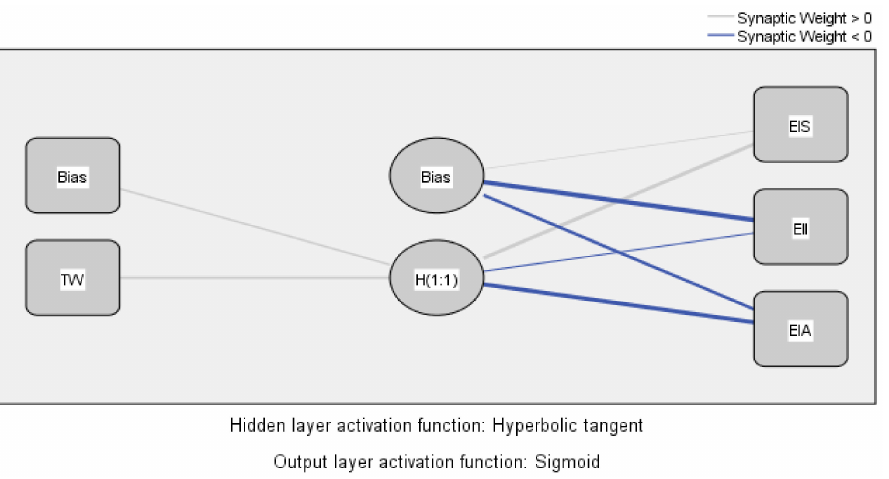
Figure 3. Multilayer perceptron model to identify the influences of telework (T.W.) on the em- ployment by sectors. Source: Developed by the authors based on the data calculated with SPSS. Note: Bias—the influences of the exogenous factors; T.W.—telework; E.I.S.—employment in